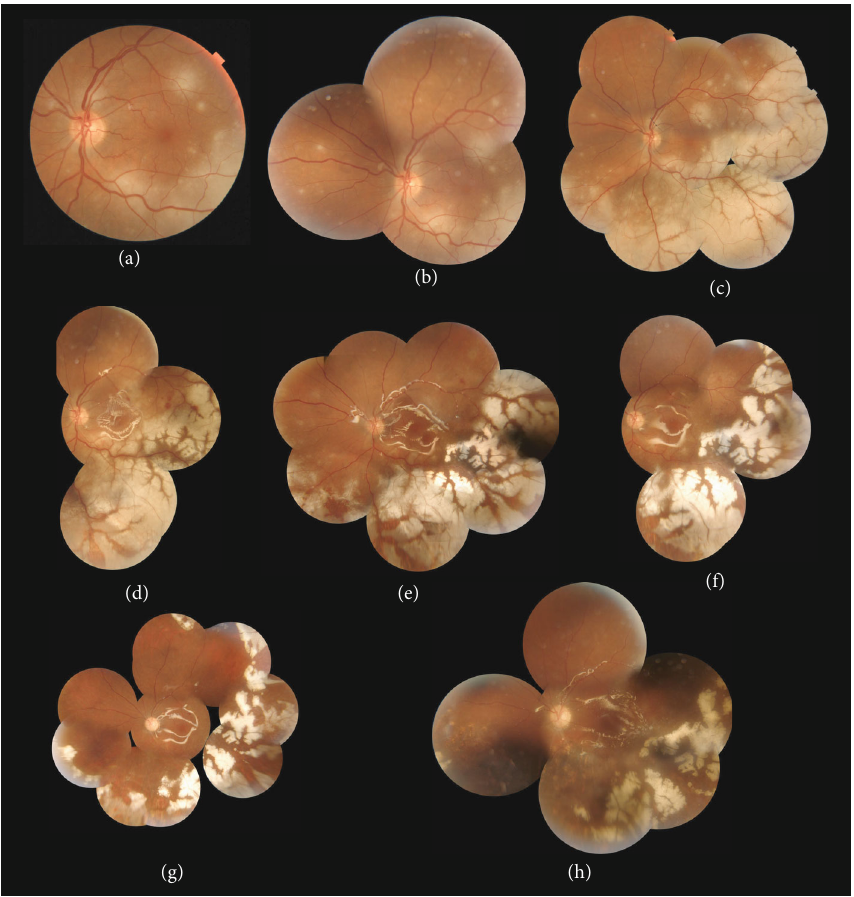
Figure 2: (a) Fundus photograph of the left eye (OS) at presentation shows white necrotic retinitis patches encroaching the macula from the inferior and temporal area. Scattered hemorrhages are evident along the inferior arcade. There is no signi fi cant vitritis. (b) Montage fundus photograph of OS on day 4: retinal lesions progressed, the intravenous acyclovir dosage was increased to 850 mg three times per day, and the second dose of intravitreal ganciclovir (2 mg/0.1 cc) was administered. (c) Three days later, despite medical treatment, the lesions coalesced and showed an increase in size. Perivascular sparing can be appreciated. (d) One day after pars plana vitrectomy with silicone oil tamponade and intravitreal ganciclovir injection. (e) On day three postoperatively, lesions regressed, especially from the macular area. (f) One week after the left eye surgery (day 20). (g) One month after vitrectomy, the lesions resolved obviously and got sharper borders. (h) Seven months after initial presentation, the lesions regressed signi fi